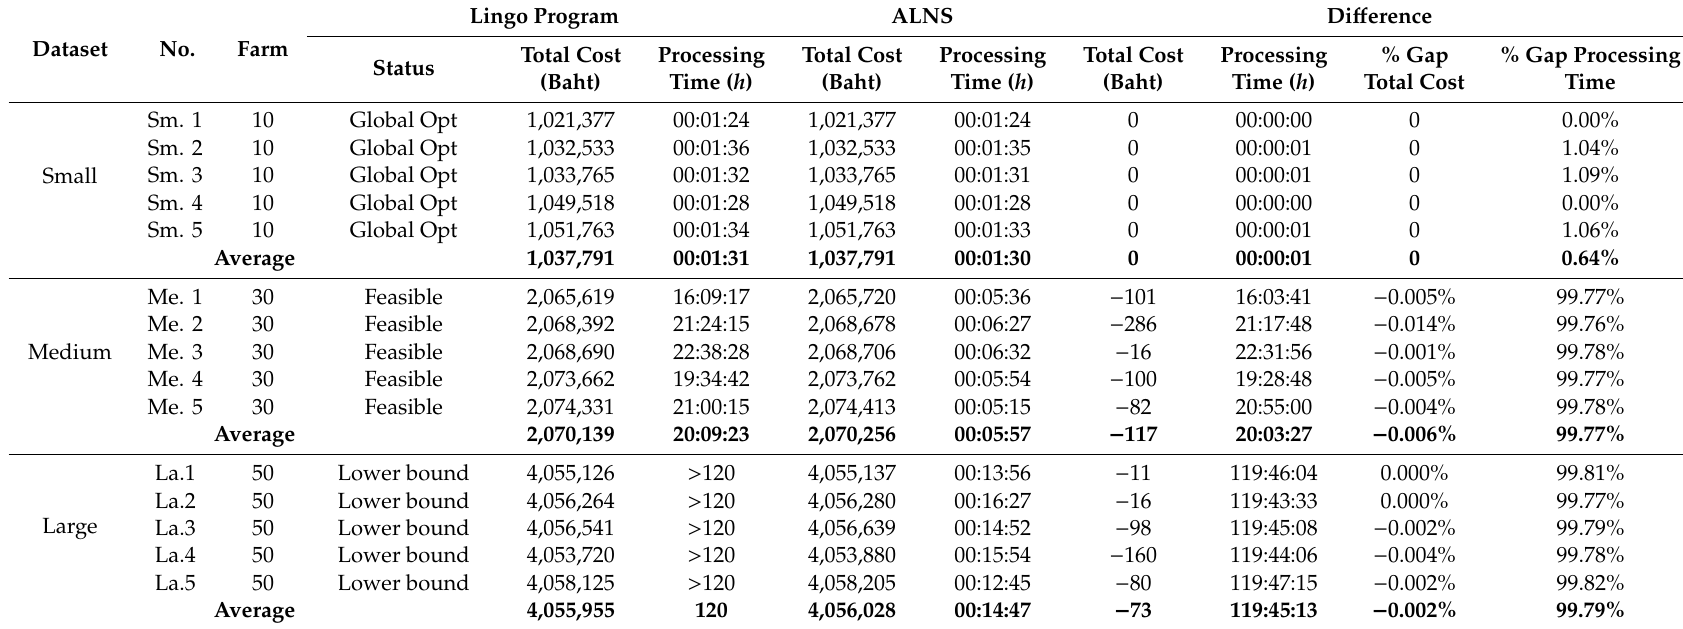
Table 6. The result comparison of exact method and ALNS